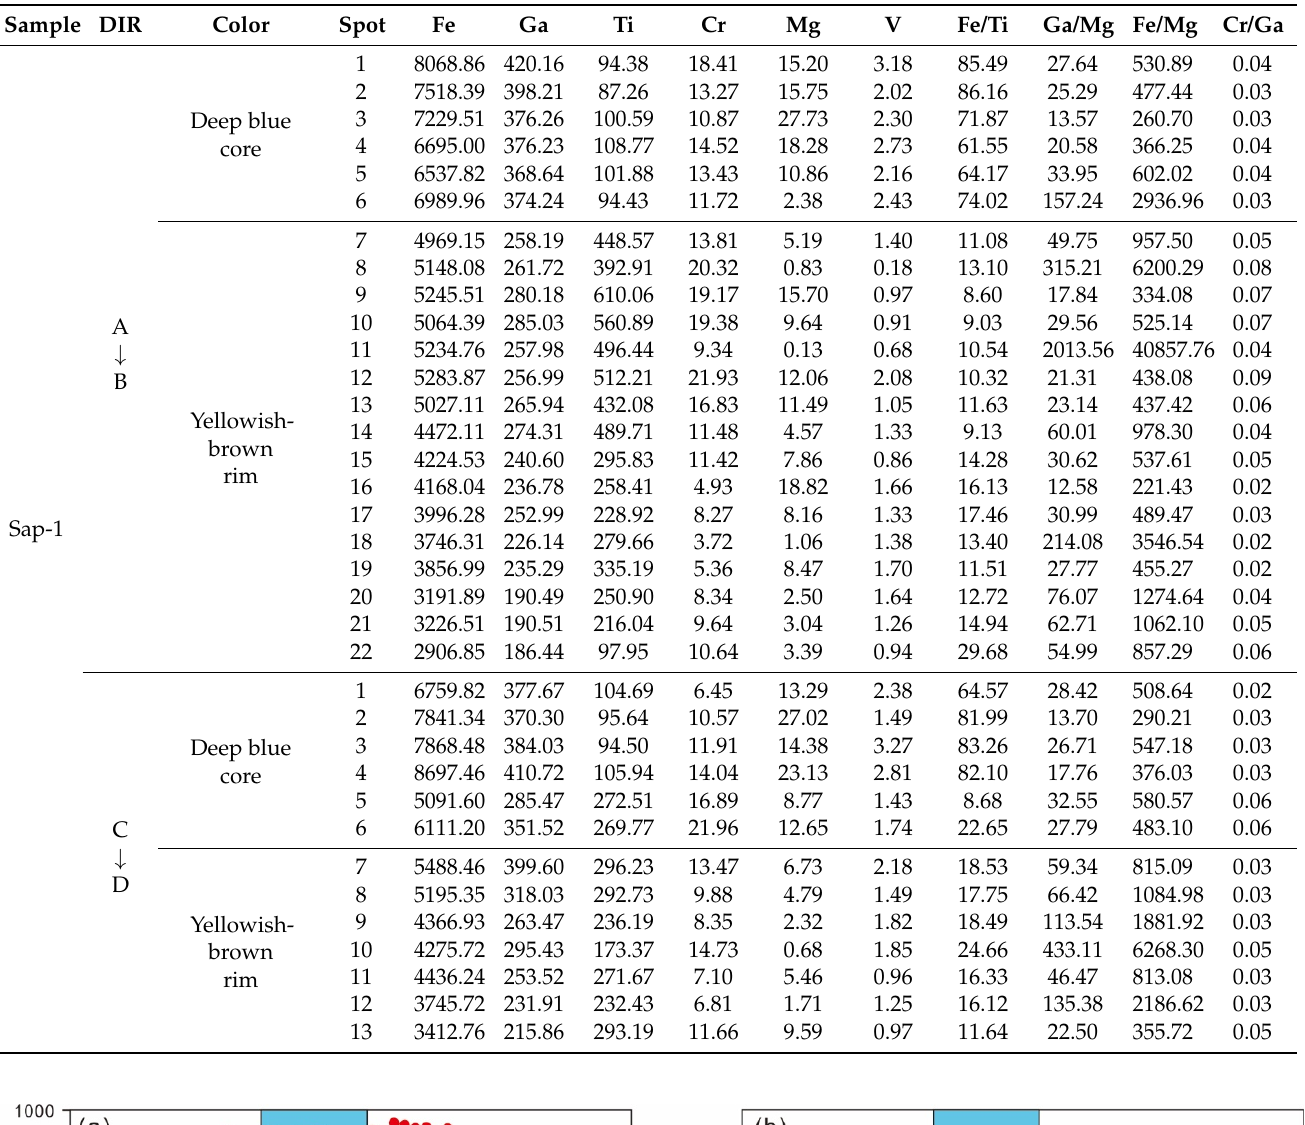
Table 1. The main trace element contents (ppm) of sample Sap-1 analyzed via LA–ICP–MS over two profiles (AB and CD) from core to rim.